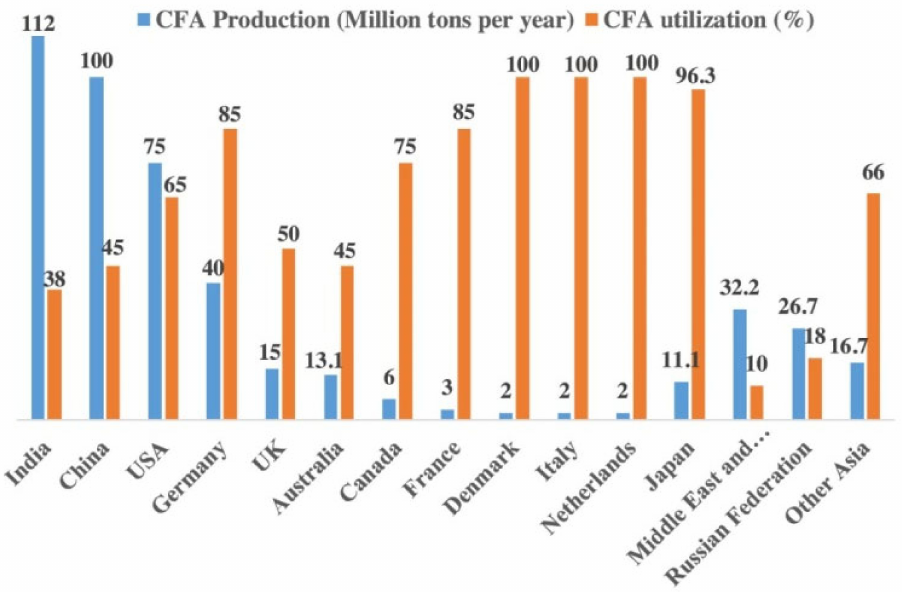
Figure 2. Production and utilization of FA globally (CFA: classified FA) [23]. Reprinted with permission from Elsevier